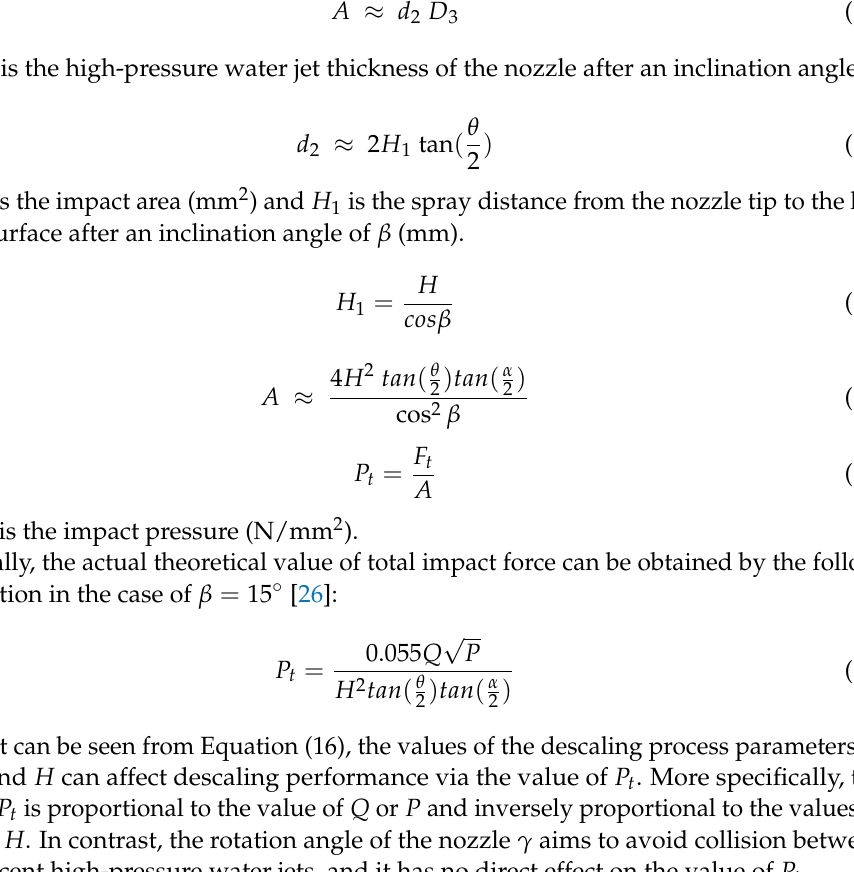
Figure 3. A schematic diagram of the physical model and meshing of hot rolling: ( a ) physical model; ( b ) unstructured grid. The other descaling process parameters of hot rolling calculated based on Equations (3)–(16) are shown in Table 1.